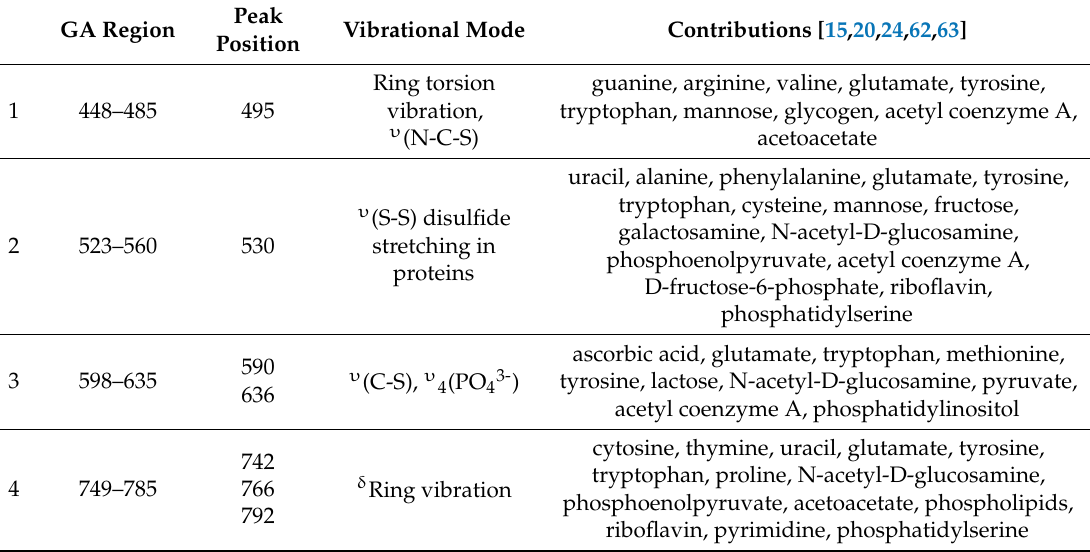
Table 3. Tentative assignments of the most important regions in the SERS spectrum of blood serum for the discrimination between AD and OD, as determined by